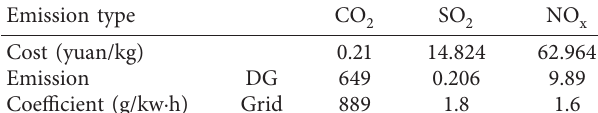
Table 2: Pollutant emission factor and disposing cost.